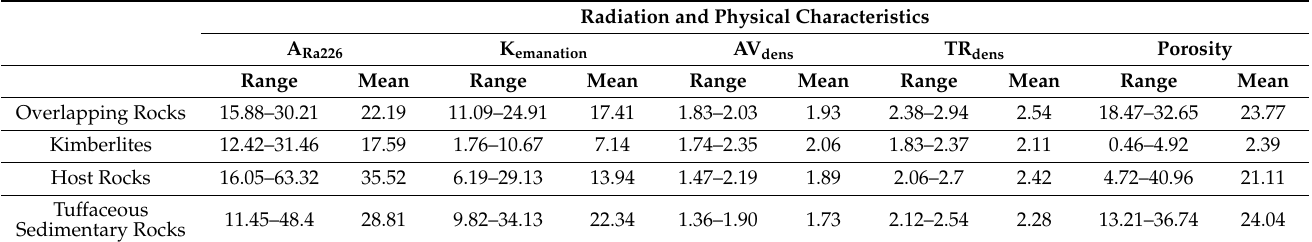
Table 2. Results of measurements of radiation and physical characteristics of samples.